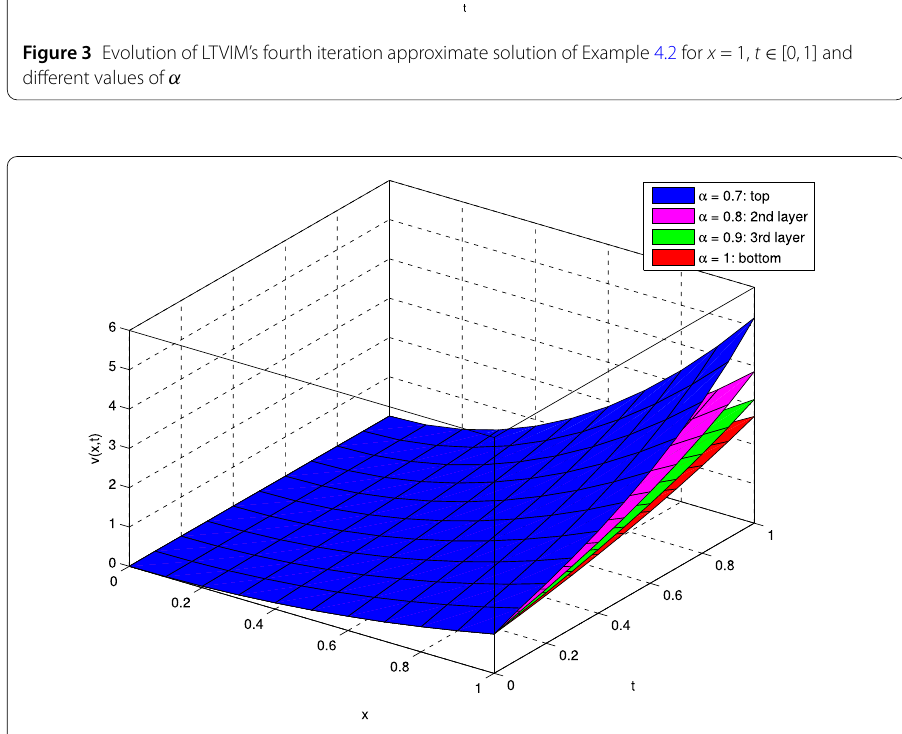
Figure 4 Evolution of surface behavior of LTVIM’s fourth iteration solution of Example 4.2 for x , t ∈ [0,1] and different values of